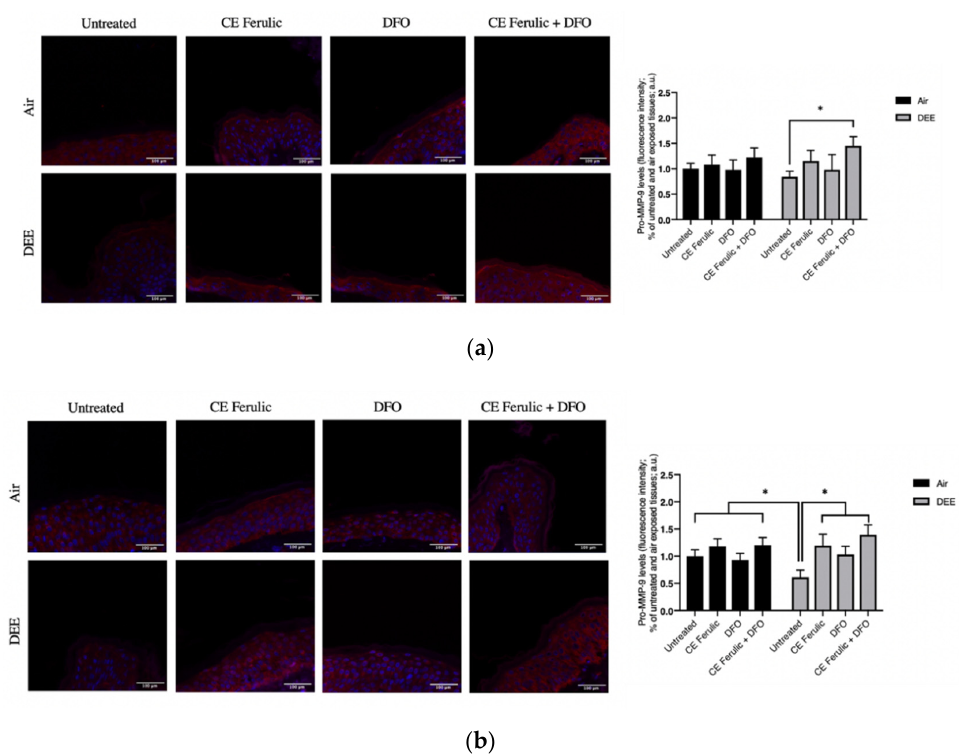
Figure 2. Skin exposure to DEE induces a decrease in the levels of pro-MMP-9, while topical application of CE Ferulic and DFO prevents this effect. Levels of pro-MMP-9 in ex vivo human skin explants untreated or pretreated with the cosmeceutical formulation mixture and DFO, alone or in combination, and exposed to air or DEE at Day 1 ( a ) and Day 4 ( b ). Red fluorescence staining represents pro-MMP-9 immunoreactivity, while cell nuclei are stained in blue with DAPI. Original magnification 40×. On the right, semi-quantification of the immunofluorescence intensities performed by ImageJ are shown in the histograms. Data are expressed as arbitrary units (averages of three independent experiments), * p < 0.05, by ANOVA. Scale bar = 100 μ m.